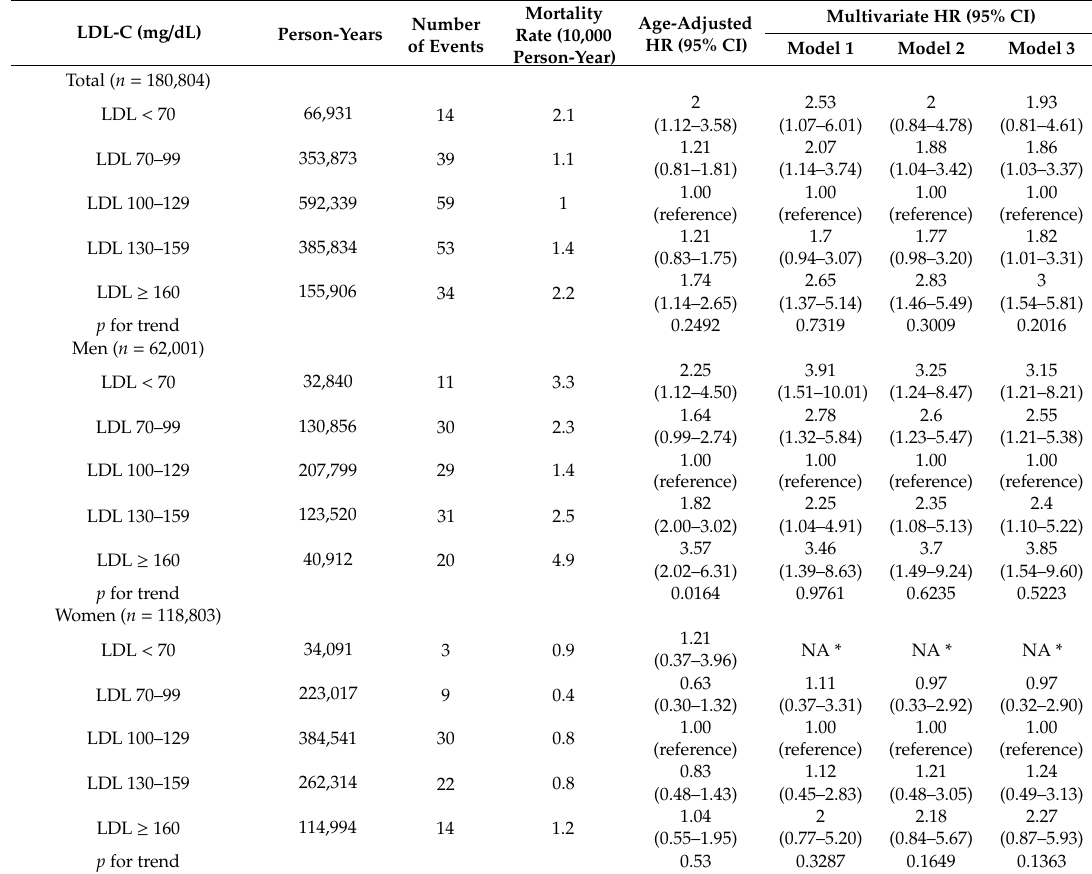
Table 6. Risk of cardiovascular disease mortality according to baseline LDL-C levels excluding subjects who died within 3 years of follow up in KOGES data.